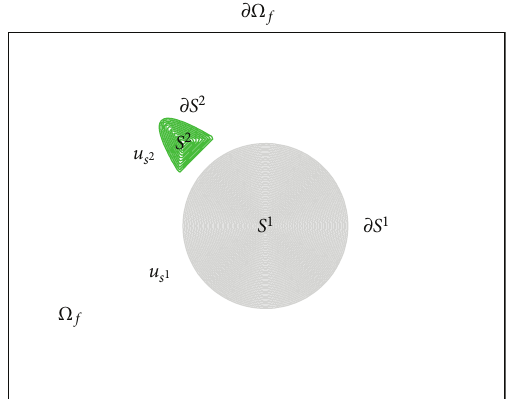
Figure 1: Schematic representation of a computational domain Ω = Ω ∪ S 1 ∪ S 2 . Ω i : solid f f : fluid domain, S